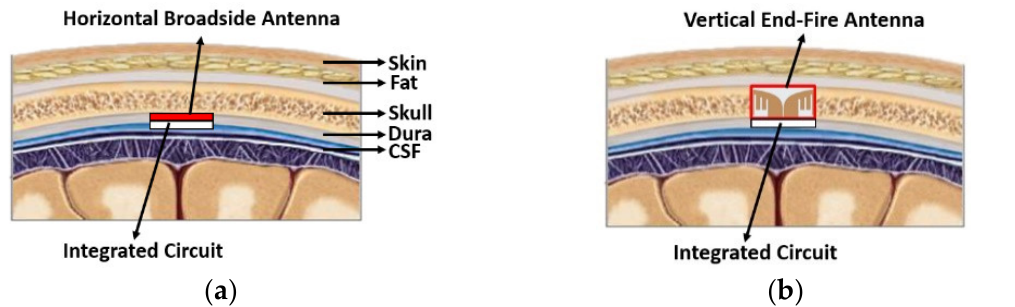
Figure 1. Conceptual illustrations of the brain-implanted antenna placement: ( a ) conventional horizontal placement and ( b ) proposed vertical placement.